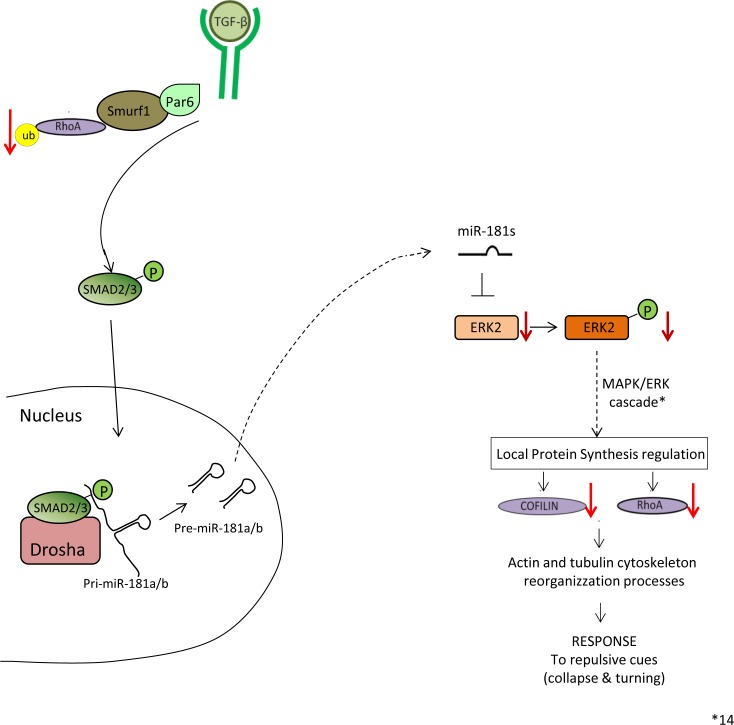
Model of TGF-β cascades in retinal axon specification and growth.The TGF-β pathway regulates axon growth in the retina via two independent and synergistic pathways: the Par6/Smurf1 and the miR-181/ERK pathways. TGF-β–mediated activation of the Par6/Smurf1 cascade leads to ubiquitination and degradation of RhoA. On the other side, TGF-β also generates increased miR-181a/b levels, enhancing the process of miRNA maturation via activation of the SMAD2/3 protein. In turn, by fine modulation of the MAPK/ERK signaling pathway, miR-181a/b has an inhibitory effect on cofilin and RhoA production.